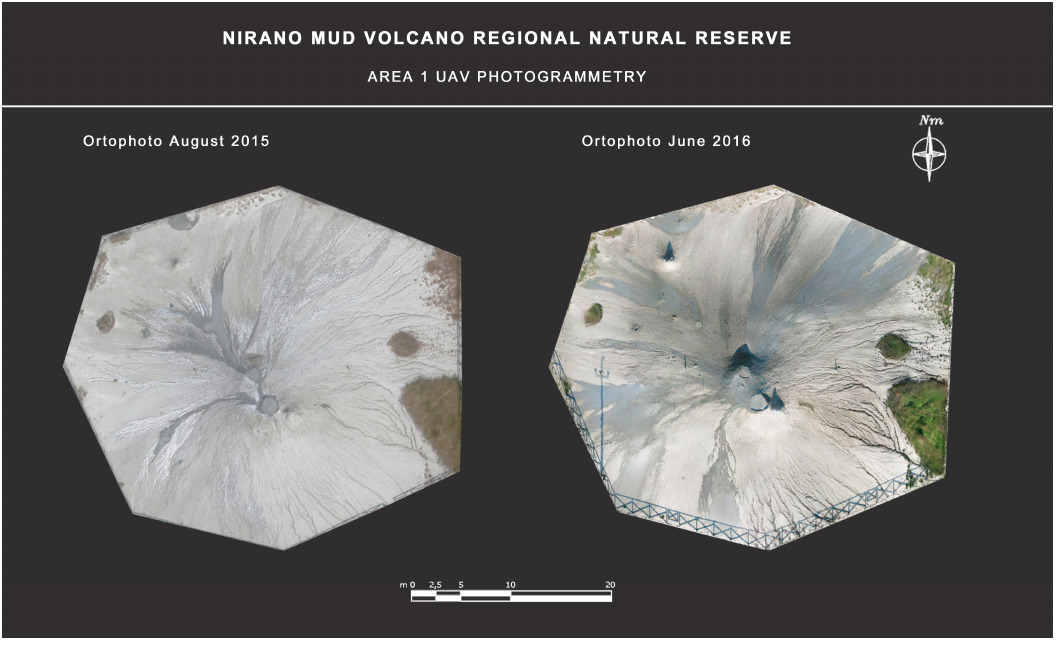
Figure 4. UAV photogrammetry comparison of the ortophotos obtained by the two survey campaigns Figure 4. realized.